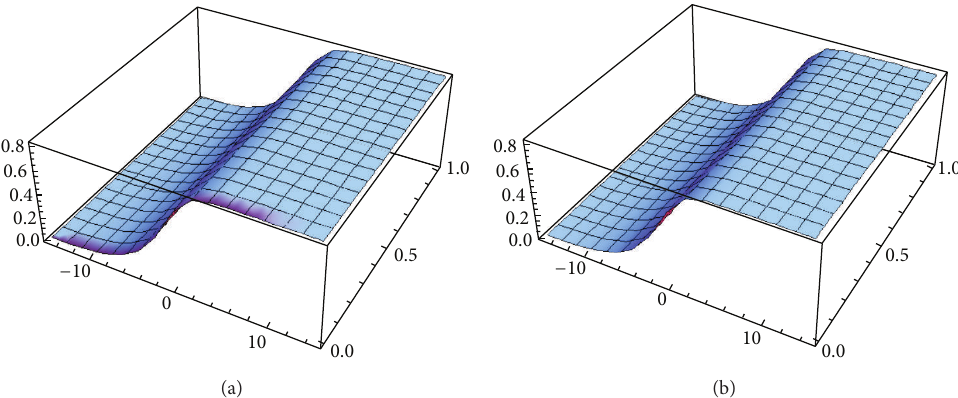
Figure 3: Graph of the solution (25) corresponding to the values 𝛼 = 0.05 , 𝛼 = 0.85 , respectively, when 𝑘 = 1 , 𝑝 = 3 , 𝑏 0 = 3 , 𝑏 1 = 1 , 𝛽 = 2 , −15 < 𝑥 < 15 , and 0 < 𝑡 < 1 .